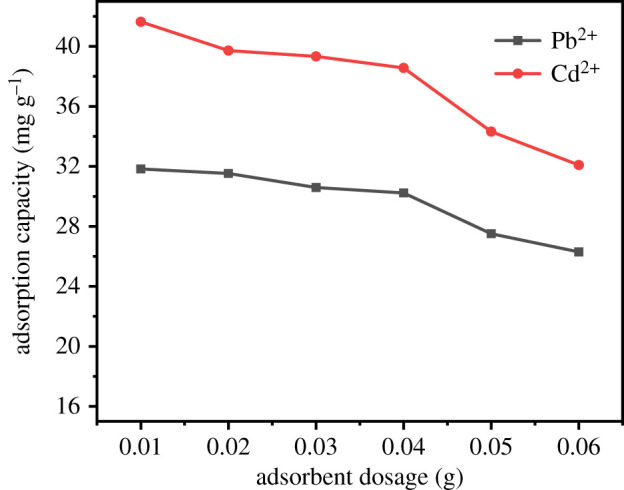
The effect of adsorbent dosage on adsorption of Pb2+ and Cd2+.